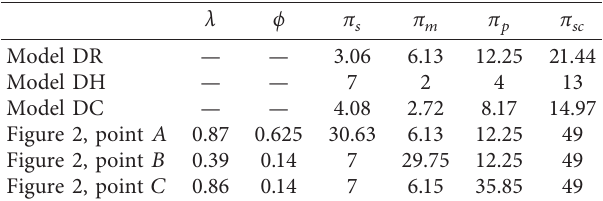
Figure 2: The range of λ and ϕ when achieving SC coordination. Table 2: Effect of the coordination contract on profits of SC members and the entire